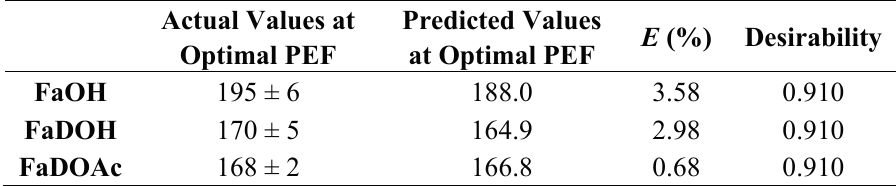
Figure 4. Response surface plot desirability of mild PEF-treated carrot slices as a function of maximal FaOH, FaDOH and FaDOAc retention keeping constant pulse frequency at 10 Hz and pulse width for 10 μ s. Table 3. Average mean deviation ( E %) values of predicted and actual values at optimal mild PEF treatment conditions set up at 4 kV/cm with 100 number of pulses of 10- μ s and at 10 Hz of pulse